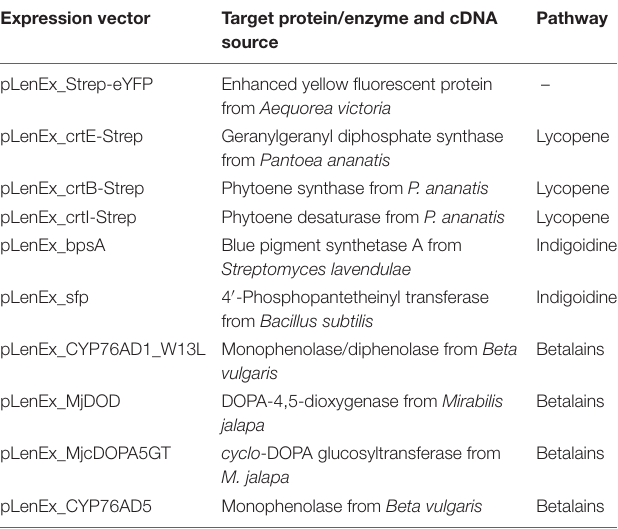
TABLE 1 | List of plasmids used in this